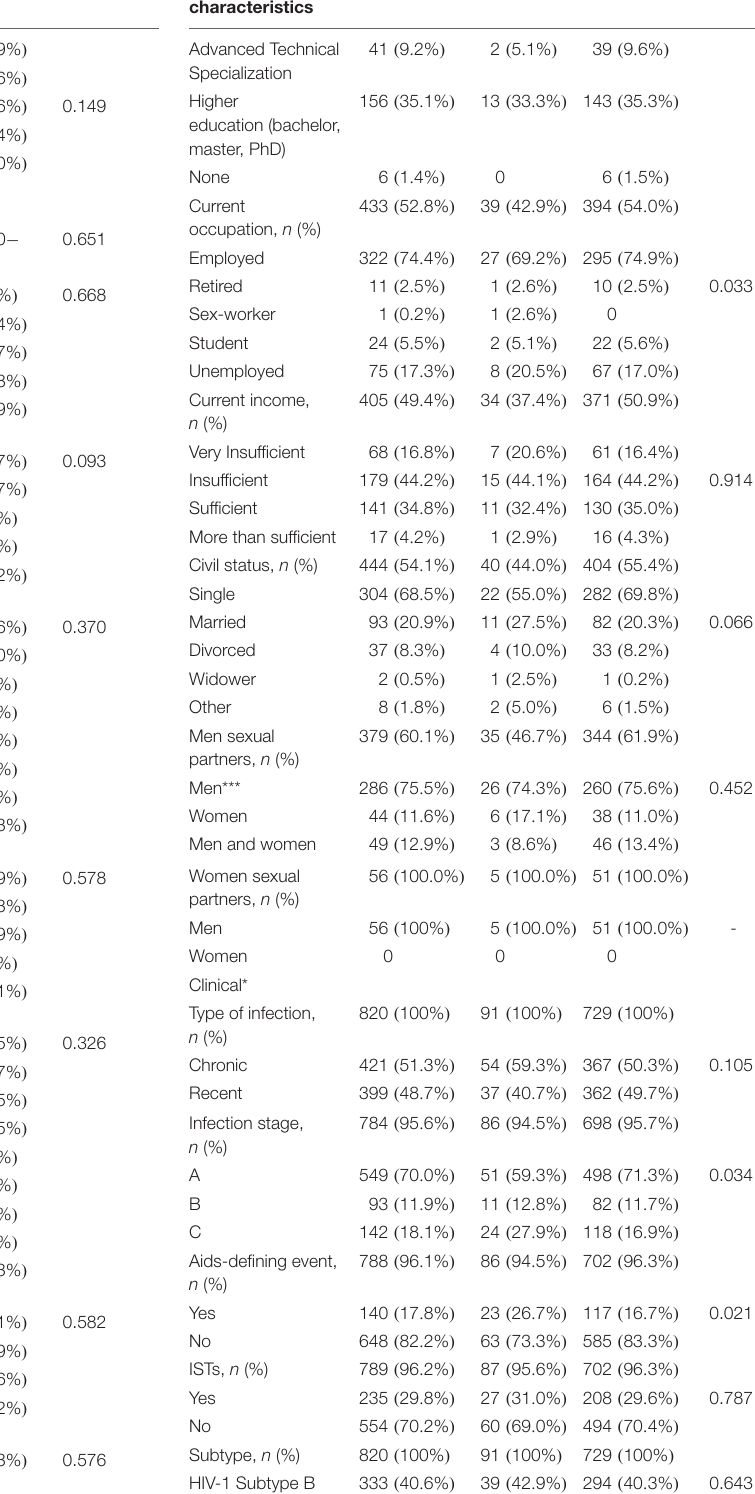
TABLE 1 | Demographic and patients